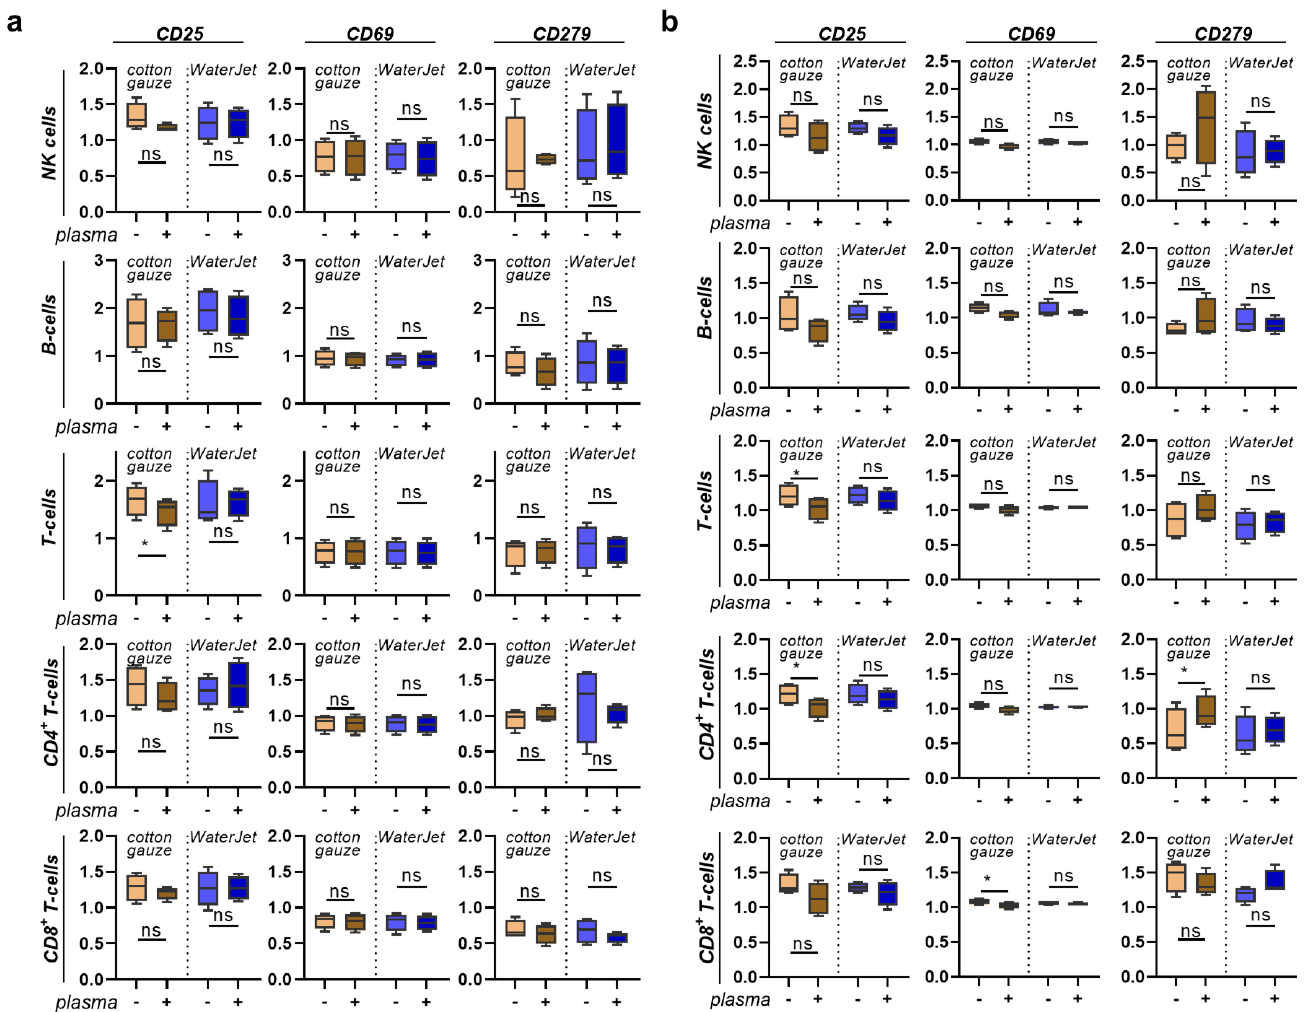
Figure A4. PBMC inflammation marker expression cultured on contaminated or clean, fixed titanium discs. ( a ) percentages of non-myeloid leukocyte subpopulations across all leukocytes in contaminated and cotton gauze, Waterjet, and/or CAP-treated titanium discs with subsequent addition of fixative; ( b ) non-myeloid percentages of leukocyte subpopulations across all leukocytes in clean and cotton gauze, Waterjet, and/or CAP-treated titanium discs with subsequent addition of fixative. Data are from four donors and show boxplots and median of data normalised to untreated fixed titanium discs. Statistical analysis was performed using paired t -test; * = p < 0.05, ns = not significant. PBMC from four different donors were tested. Biofilm was generated from subgingival plaque of a single periodontally diseased individual.